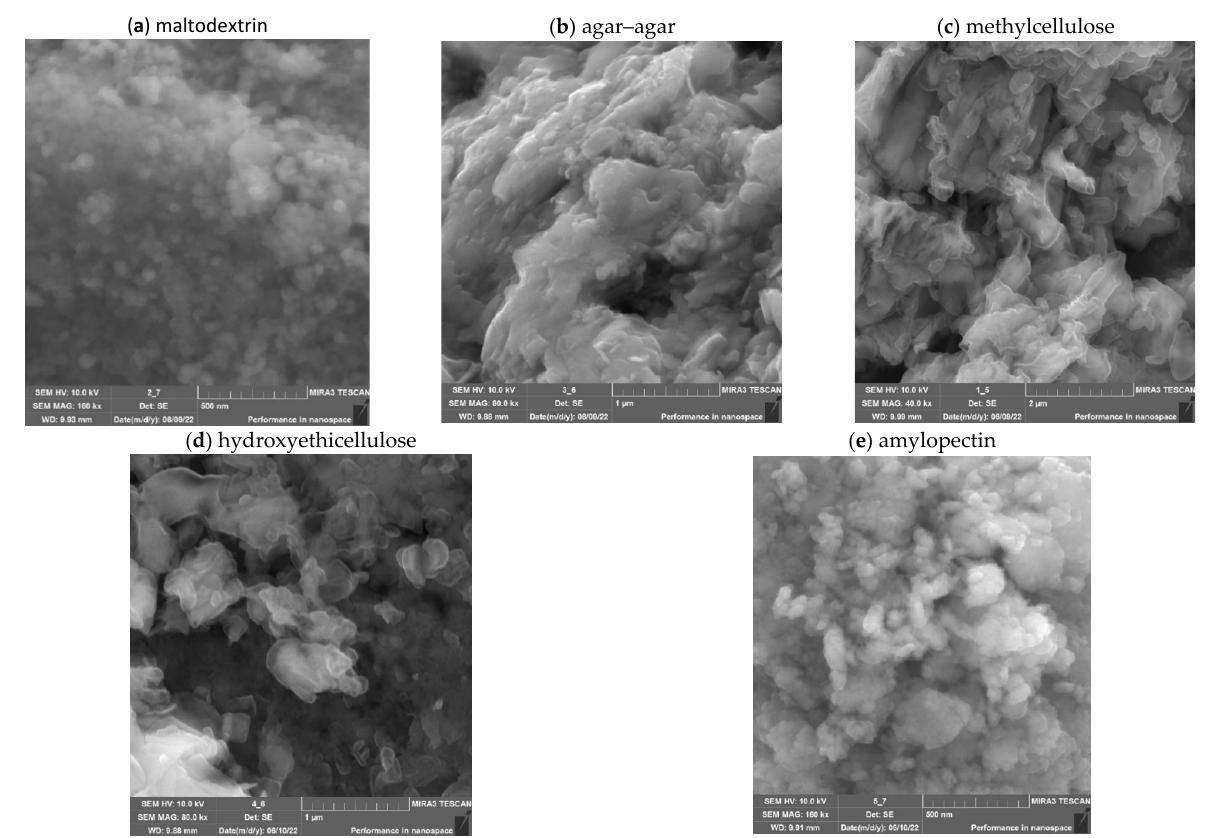
Figure 6. SEM micrographs of nanoscale ZnO stabilized with polysaccharides.